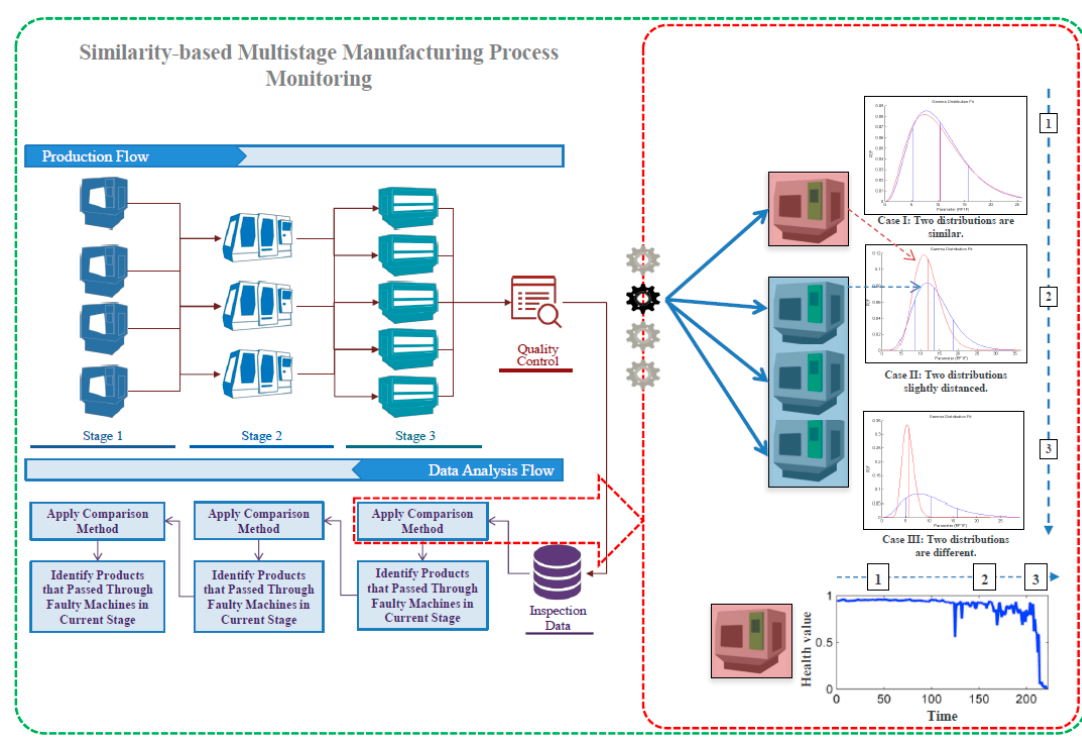
Figure 1. The proposed framework for similarity-based multistage manufacturing process monitoring using product quality data [25].